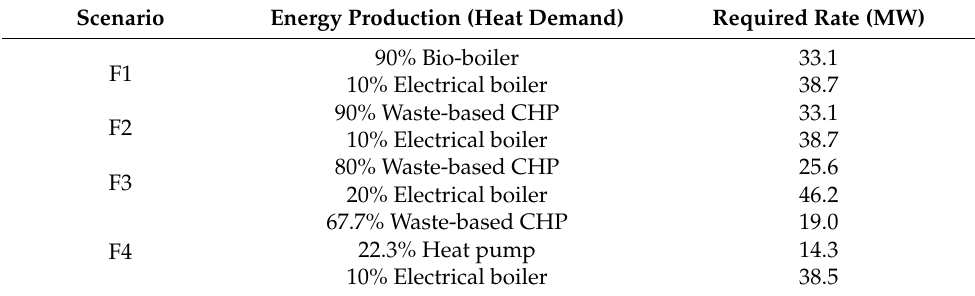
Table 5. Scenarios of energy supply combination. CHP, combined heat and power.